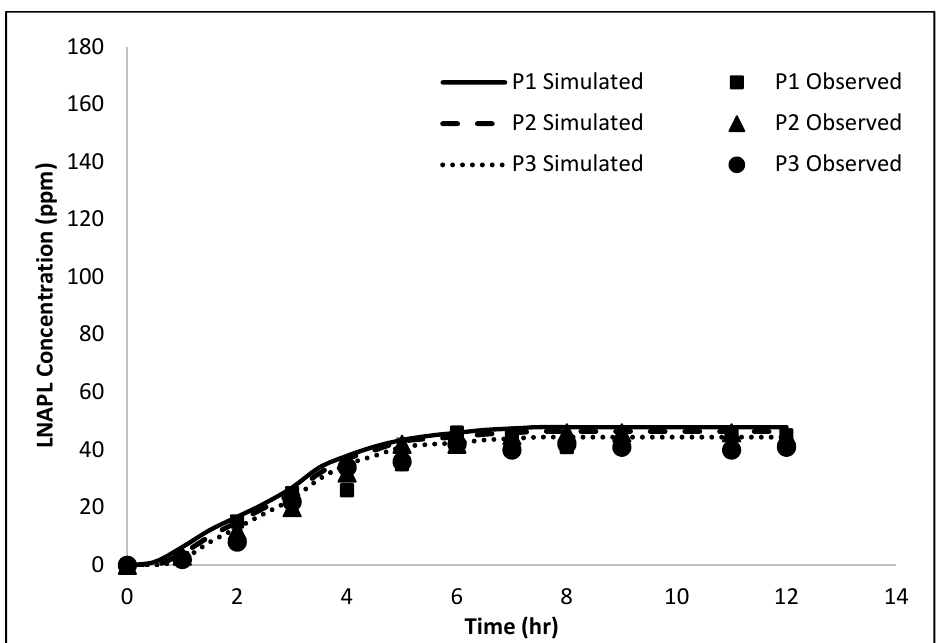
Figure 4. Concentration of NAPL at sampling ports P1, P2, and P3 of column setup at soil-water temperature of 20 °C.